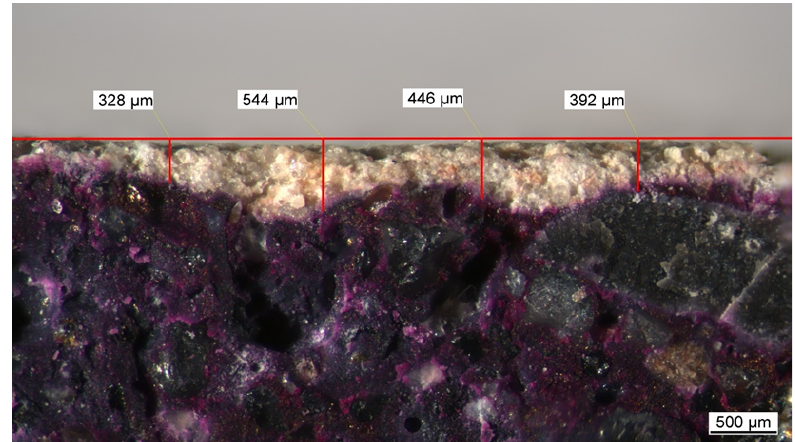
Figure 8. Microscopic image of a concrete specimen after 91 days of storage in sulfuric acid.